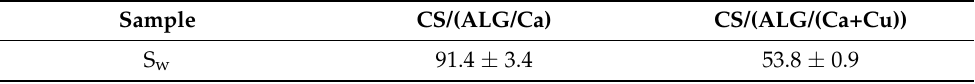
Table 5. Swelling degree (S w ) of CS/(ALG/Ca) and CS/(ALG/(Ca+Cu)) microcapsules. Sample CS/(ALG/Ca) CS/(ALG/(Ca+Cu)) S w 91.4 ± 3.4 53.8 ±